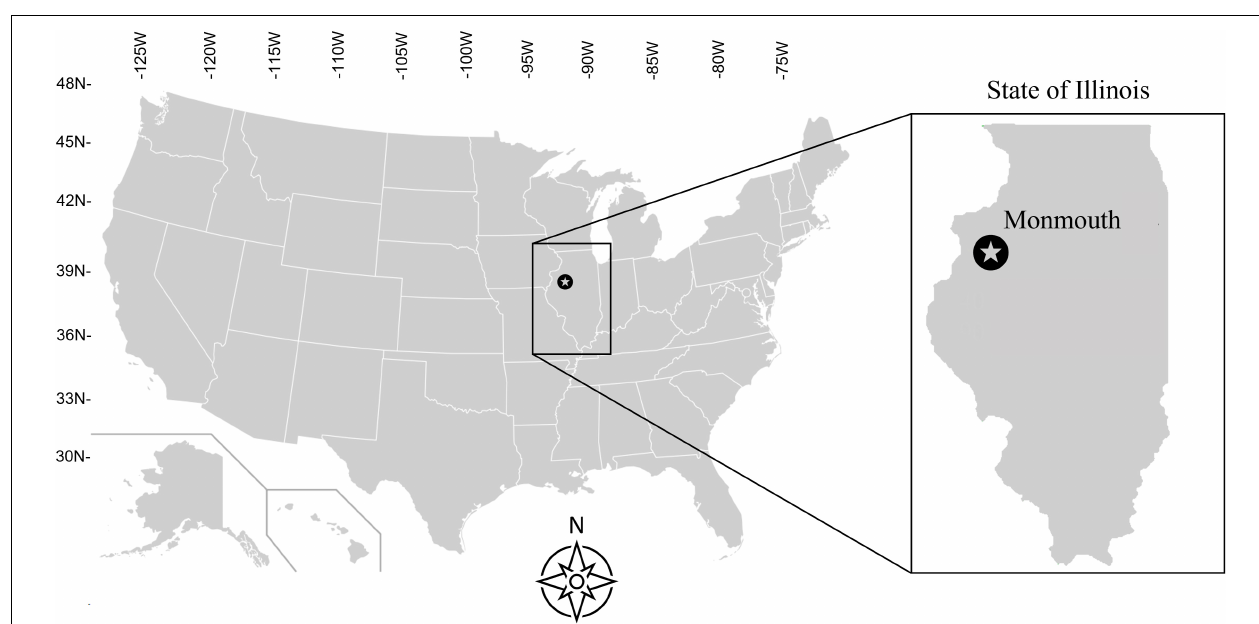
FIGURE 1 | Location and coordinates of the experimental site within the United States and the state of